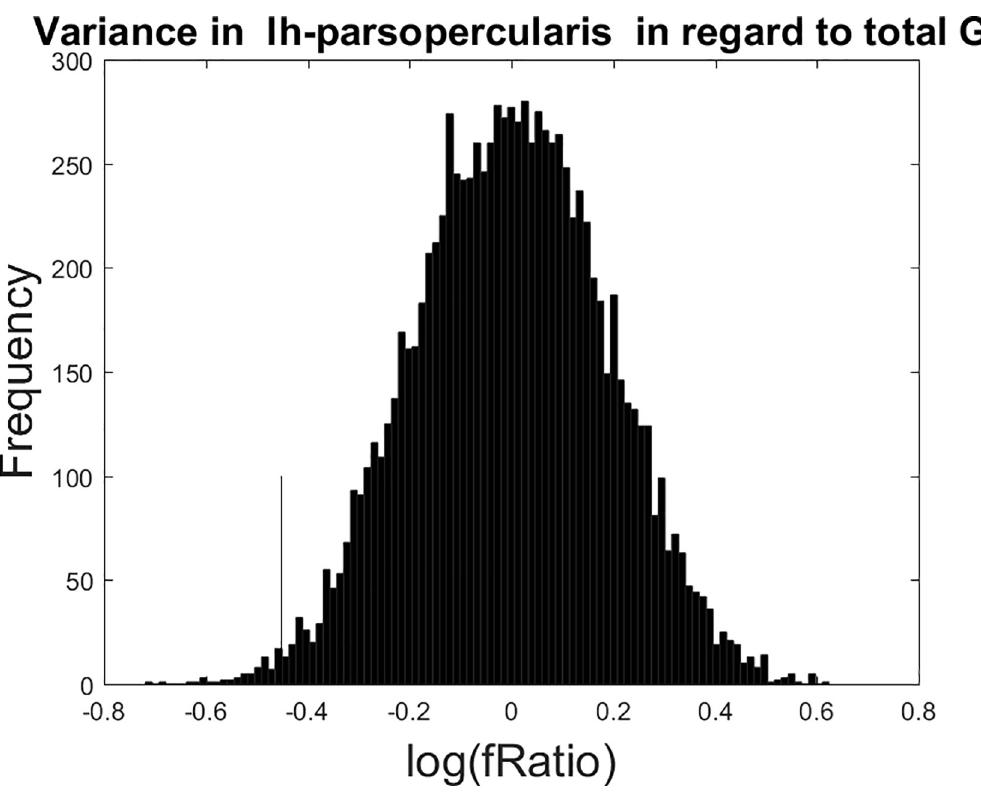
Fig 1. Non-parametric permutation F-test with 10,000 iterations for the residualized thickness variance with respect to total cognition. In this region, the left pars opercularis, higher total cognition is associated with lower thickness variance at p = 0.0129 (uncorrected for multiple comparisons). The point estimate for the log-F statistic is shown with a thin black line in the left tail of the